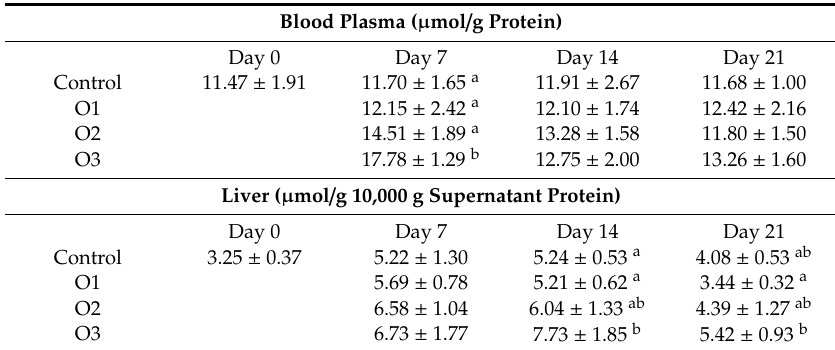
Table 5. E ff ect of Ochratoxin A treatment on reduced glutathione concentration in blood plasma and liver homogenates (mean ± SD; n = 6).